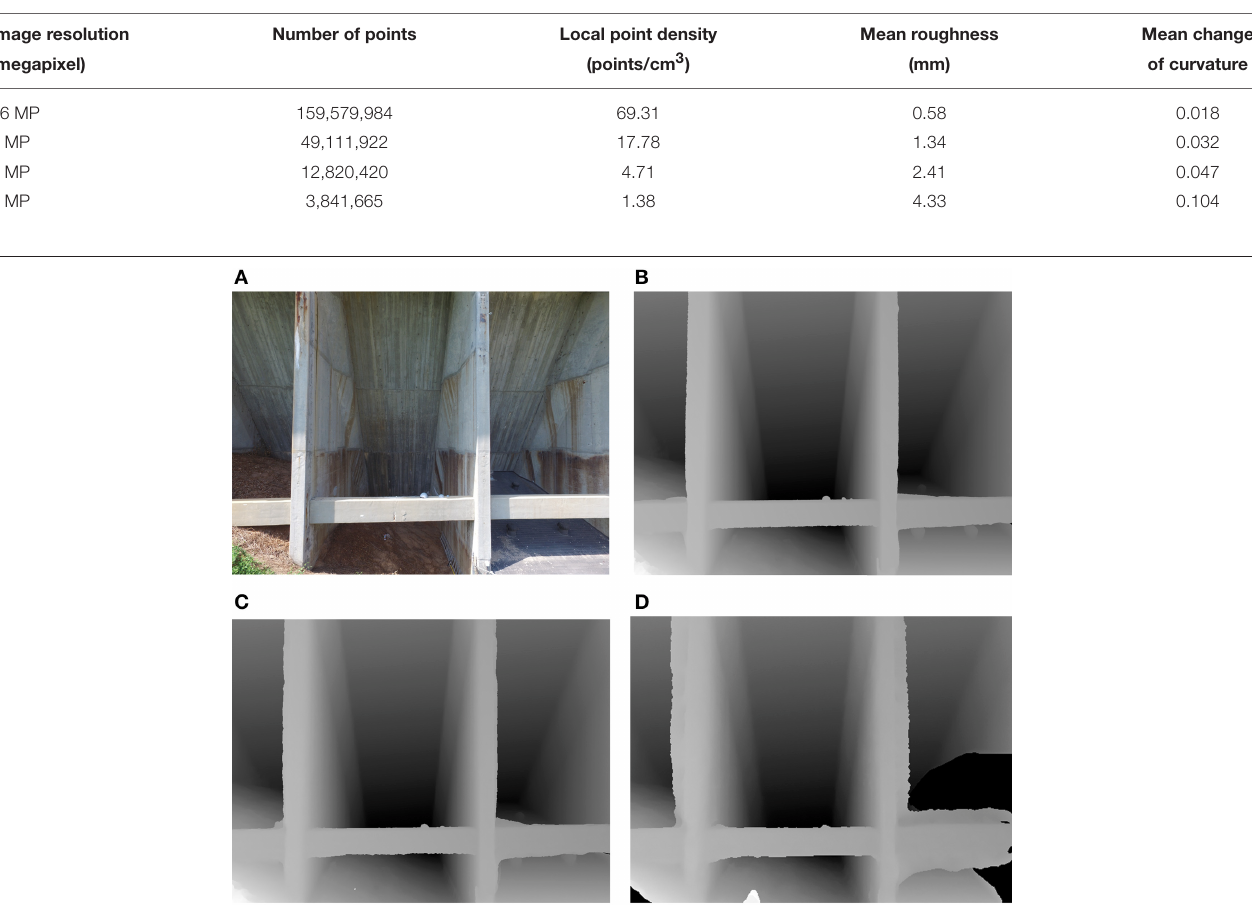
TABLE 4 | Bay #5 3D point cloud generation using various image